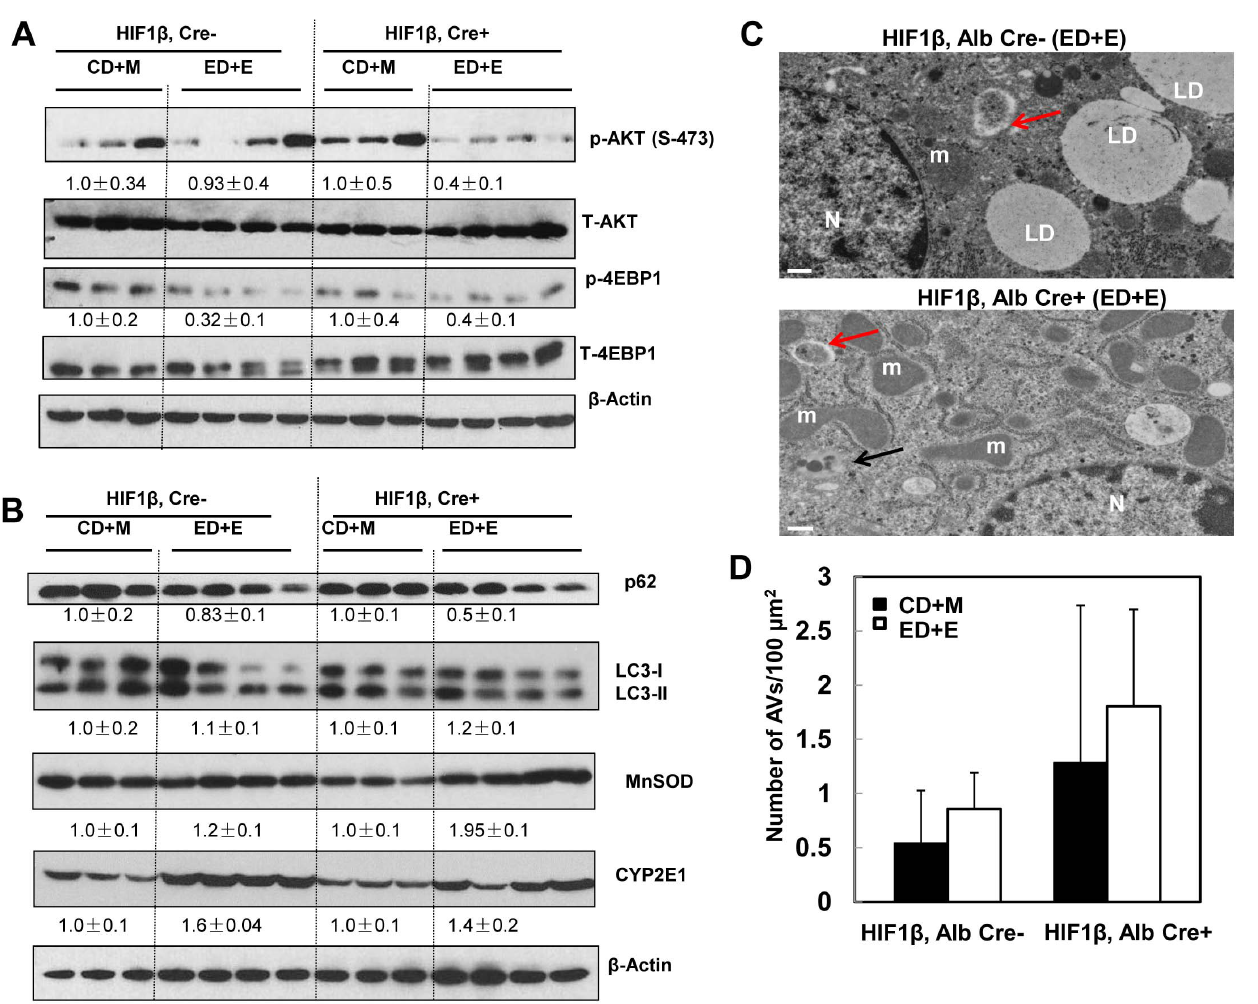
Fig. 8. Inhibition of AKT and mTOR and induction of autophagy in hepatocyte-specific HIF-1 b knockout mouse livers after Gao-binge treatment. Age matched male wild type and hepatocyte-specific HIF-1 b knockout mice were subjected to Gao-binge treatment. (A & B) Total liver lysates were subjected to western blot analysis for the indicated proteins. Densitometry was performed and data are presented as a ratio of CD + M control group (n 5 3–4). Representative EM images are shown in (C). M: Mitochondria; N: Nuclei; LD: lipid droplet; Bar: 500 nm. Red arrows: autophagosomes, black arrows: autolysosomes. (D) The number of autophagic vacuoles (AVs, including both autophagosomes and autolysosomes) per 100 m m 2 cytosol was quantified, and data are presented as means ¡ SE (more than 15 cell